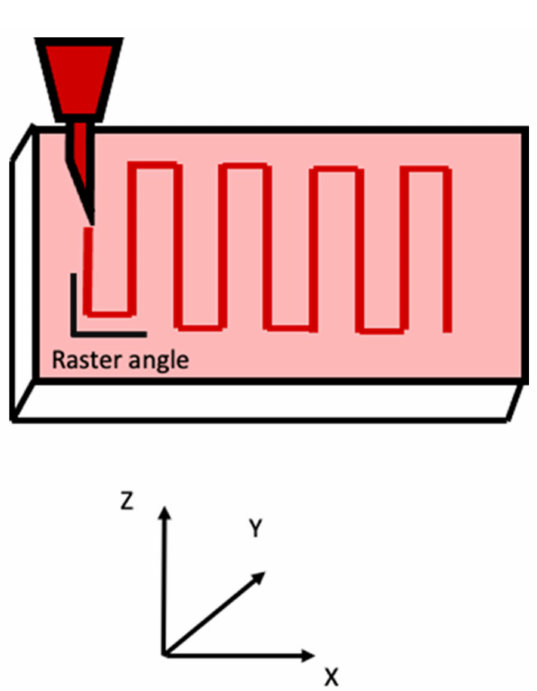
Figure 6. Raster